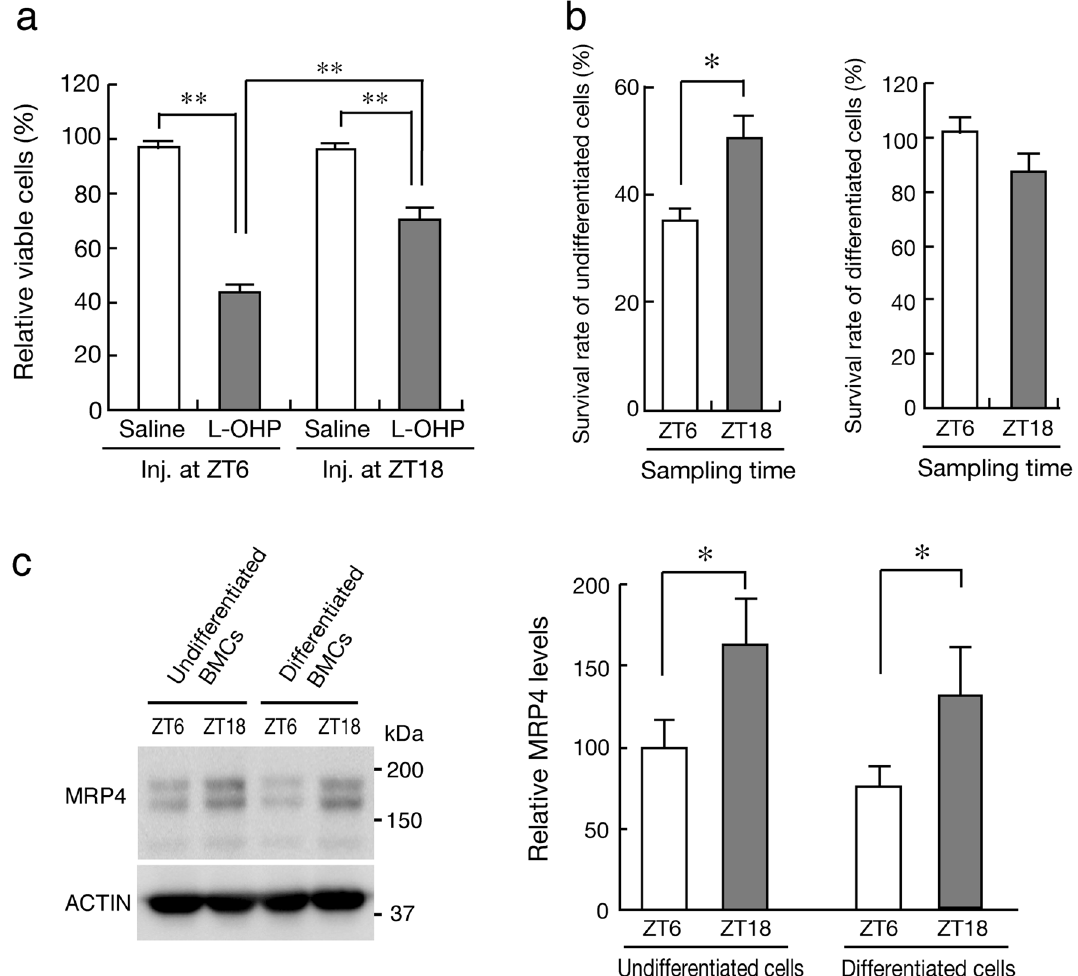
Figure 3. Dosing time-dependent difference in L-OHP-induced myelotoxicity in mice. ( a ) The decrease in the number of viable BMCs in mice at 72 h after injecting L-OHP (20 mg/kg, i.v.) or saline at ZT6 and ZT18. Cell viability was assessed by staining with calcein-AM on FACS. Values are the mean with S.D. (n = 4). ** P < 0.01, significant difference between the two groups ( F 3,12 = 9.361, P < 0.001, ANOVA with Tukey–Kramer’s post-hoc test). ( b ) The survival rate of undifferentiated (left) and differentiated (right) BMCs after injecting L-OHP (20 mg/kg, i.v.) or saline at ZT6 and ZT18. Lineage-positive and -negative BMCs were separated by FACS as undifferentiated and differentiated cells, respectively. Values are the mean with S.D. (n = 8). * P < 0.05, significant difference between the two groups ( t 14 = 3.045, P = 0.012, unpaired t-test, two-sided). ( c ) Temporal expression profiles of MRP4 in undifferentiated and differentiated cells prepared from bone marrow of mice. Values are the mean with S.D. (n = 6). * P < 0.05, significant difference between the two groups ( F 3,20 = 14.892, P < 0.001, ANOVA with Tukey–Kramer’s post-hoc test). Full-size images of western blotting are presented in Supplementary Fig.